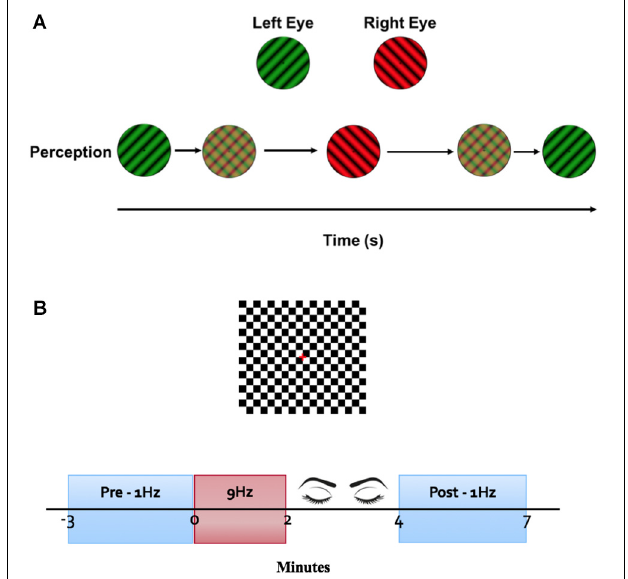
FIGURE 1 | Experimental protocol. (A) Binocular rivalry stimulus. A luminance-matched dichoptic grating was presented on a black background. Participants wearing red/green glasses used a keyboard to report perception of stimulus. (B) VEP stimulus. Onset and offset of a black and white checkerboard was presented on a luminance-matched gray background. VEPs were averaged for 3 min at a stimulus frequency of 1 Hz as pre and post measurements. Immediately following the baseline VEP measurement, a tetanization block of stimuli presented at 9 Hz was presented for 2 min. Participants closed their eyes for 2 min before the post tetinization VEPs were recorded.